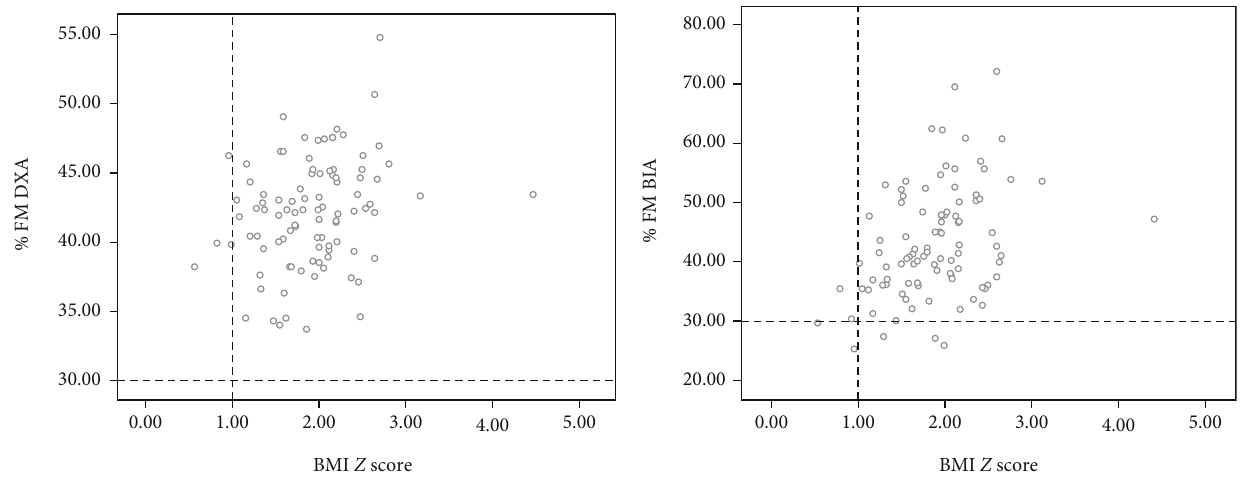
Figure 4: Di ff erences between DXA and BIA in the measurement of percentage fat mass in overweight or obese